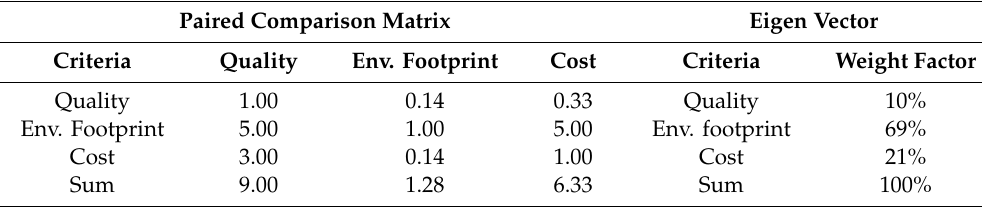
Table 11. Paired comparison matrix level 1 by prioritizing to minimize the Environmental footprint (left) and the derived normalized Eigen vector (AHP priority vector)